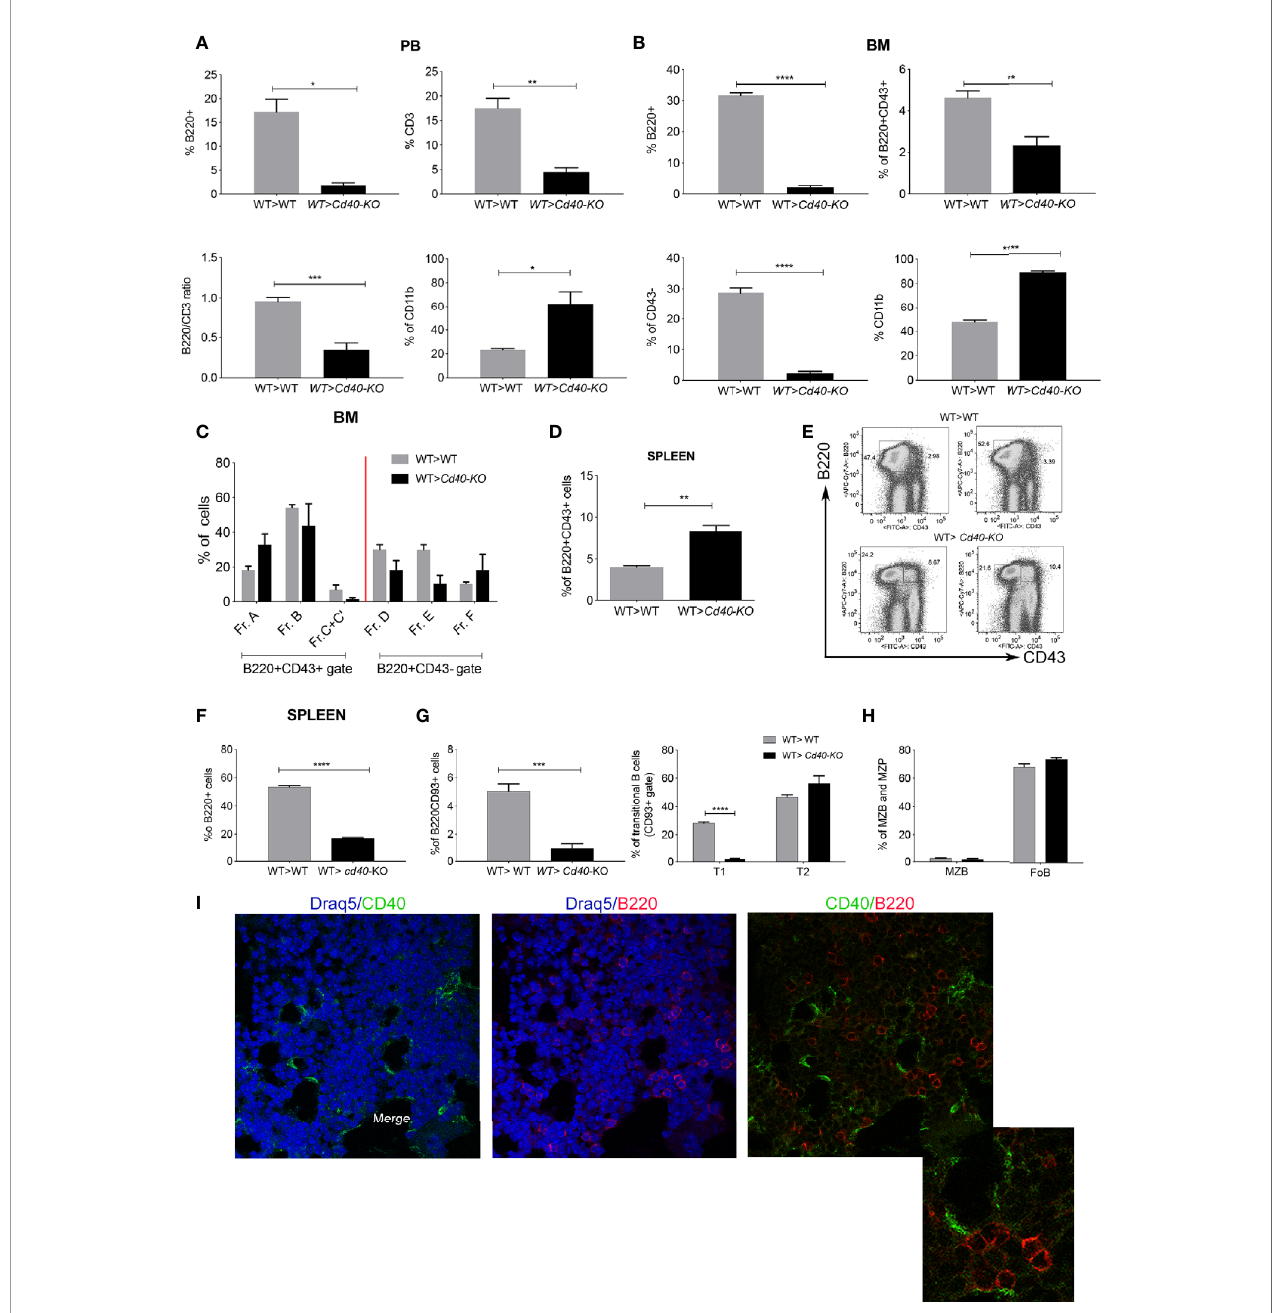
FIGURE 1 | Analysis of B-cell development in WT>WT and WT> Cd40 -KO BM chimeras. (A) Cumulative data from PB FACS analysis showing the frequencies of B220+, CD3+, and CD11b+ cells and also the B220/CD3 ratio in the PB of WT> Cd40- KO compared to those of WT>WT BM chimeras. Representative plots and gating strategies are shown in Supplementary Figure 2A . (B) Cumulative FACS analysis of the BM showing the overall decrease in B220+CD43+ and B220 +CD43- B-cell subsets in Cd40- KO recipients along with the increase in the frequency of CD11b+ myeloid cells (C) Cumulative data showing the frequency of pre- pro-B and early pro-B precursors (A and B fractions) and of late pro-B and large pre-B precursors (C ’ -C) in chimeric mice. (D) Cumulative data showing the frequency of B220+CD43+ B-cell precursors in the spleens of Cd40- KO recipient mice. (E) Representative dot plots showing that B220+CD43+ cells are nearly absent in the spleens of WT but not Cd40- KO recipients. (F) Frequency of B220+ B-cells is lower in the spleen of chimeric mice than it is in WT mice. (G) Frequency of B220+CD93+ and B220+CD93- B-cells in the spleens of chimeric mice. Splenic immature B220+CD93+ B-cell are divided into transitional T1, T2, and T3 cells based on expression of CD23 and IgM (T1 = IgM + CD23-, T2 = IgM + CD23+, T3 = IgM low CD23+). (H) Frequency of MZB and FoB within the gate of B220+CD93- cells is also highlighted. The relative gating strategy is shown in Supplementary Figure 2 . For all panels, the data are derived from 5 mice/group and are representative of one experiment out of 3 performed. Statistical analysis: Student ’ s t test (*p <0.05, **p < 0.005, ***p < 0.001, ****p < 0.0001). (I) Immuno fl uorescence analysis showing CD40+ elements in green and B220+ B-cells in